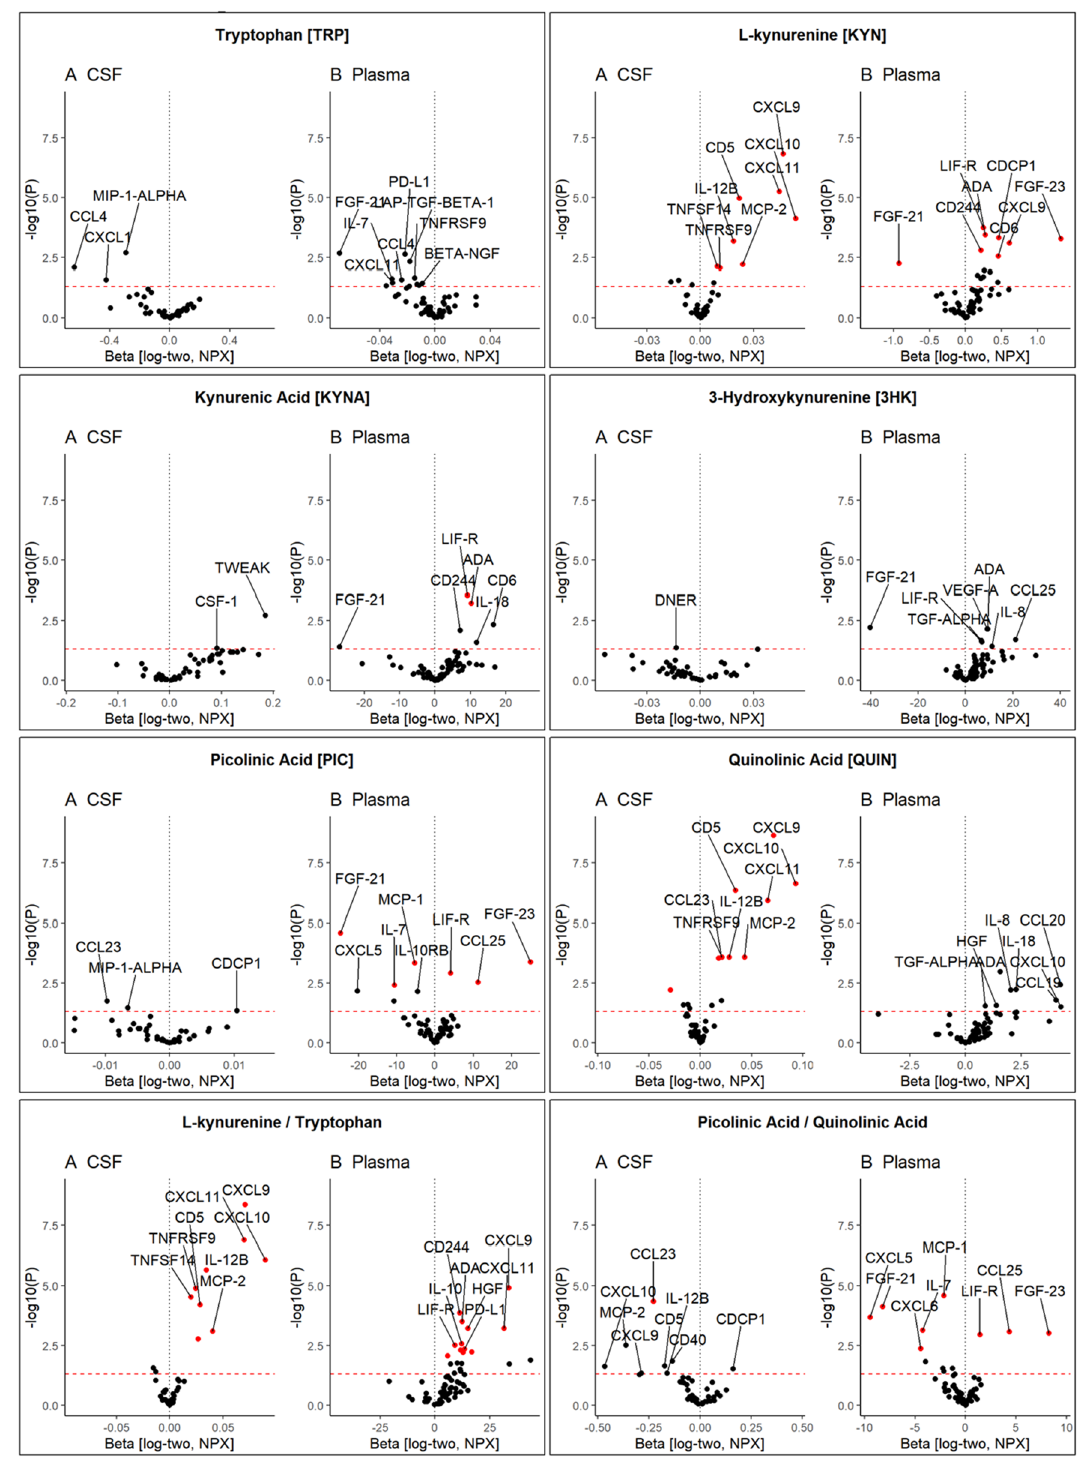
Figure 4. Correlation between tryptophan and kynurenine pathway metabolites and immune-related protein levels. Volcano plots summarize the effect size (B) and significance ( P ) from linear regression analyses between metabolite and protein levels adjusted for age at baseline, sex, intervention, and sample handling variability. Red dashed line indicates an exploratory cutoff of P = 0.05 and associations with P FDR < 0.05 are highlighted red. R: A language and environment for statistical computing. R Foundation for Statistical Computing, Vienna, Austria. URL https:// www.R- proje ct.